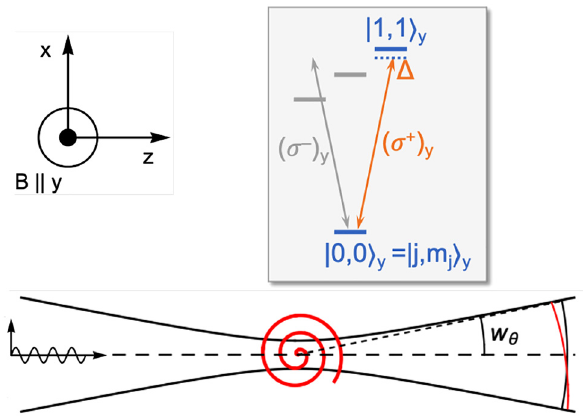
Figure 2: Optical analog of the Magnus effect. A linearly polarized ( E ∥ x ), focused laser induces a circular dipole ( xz plane) on a = 1) transition, with a magnetic field B ∥ y j = 0 → j ′ = 1 ( Δ m j setting the quantization axis. The spiral wave scattered by the circular dipole interferes with the incident wave. Due to the relative tilt between the wavefronts (exaggerated for clarity), interference may shift the optical power to one side of the beam, thus deflecting the beam in the xz plane. The corresponding reaction force on the atom, can shift the equilibrium trapping position in an optical tweezer away from the optical axis by an amount λ = 𝜆 ∕ 2 𝜋 , see text and Figure